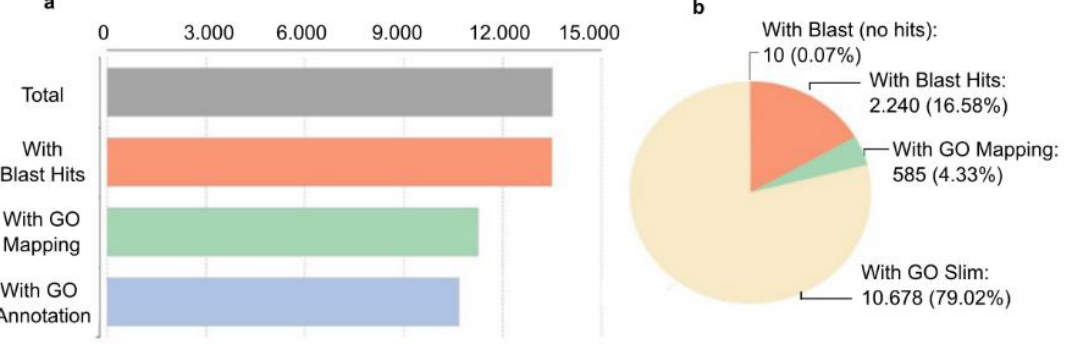
Figure 5. Characterization of H. vulgare de novo reference transcriptome. Transcripts at the gene level were annotated based on NCBI non-redundant (nr) Viridiplantae database search (downloaded in 2022.03). To annotate genes with GO slim terms, annotations and search all ancestors of the terms up to the root of the ontology tree were determined. The ancestor’s terms which are part of the slim subset were selected. ( a ) The number of annotated transcripts. ( b ) Percent distribution of annotation hits.